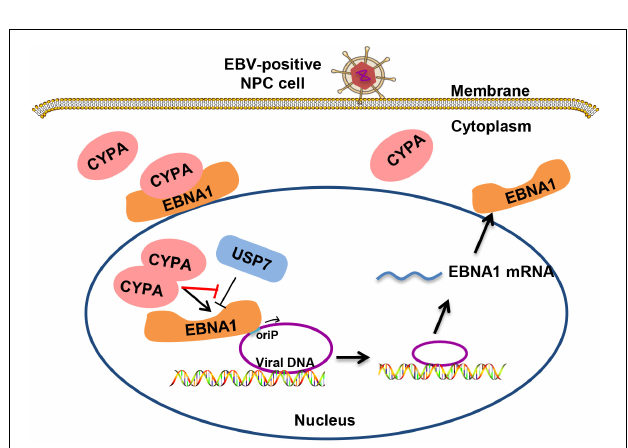
FIGURE 7 | Schematic for the mechanism of CYPA in supporting the replication function of EBNA1. EBV genomic DNA exists within the host genome in the form of extrachromosomal episomes. Cytoplasmic CYPA can be hijacked by EBNA1 into the nucleus. Overexpressed CYPA can overcome the suppression of USP7 in binding to EBNA1. Nuclear CYPA mediates EBNA1-oriP transcription, and thus contributing to the viral genome replication and